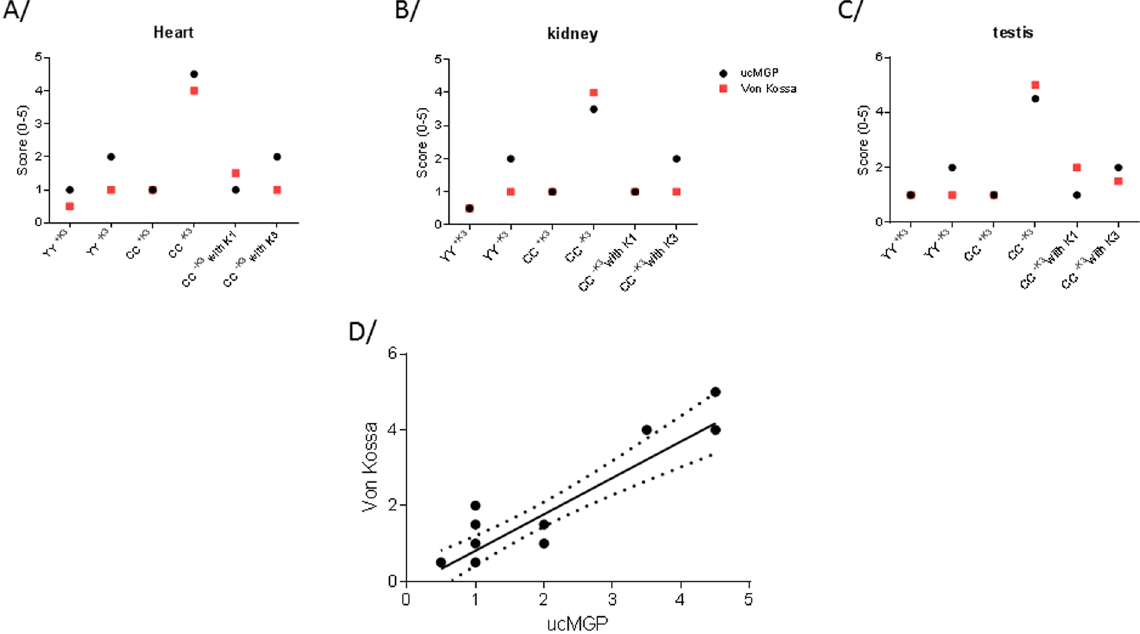
Figure 5. Score of ucMGP immunostaining and Von Kossa staining in heart ( A ), kidney ( B ) and testis ( C ) and correlation between ucMGP and Von Kossa staining ( D ). In D, the line corresponds to the linear regression with its 95% confidence interval in dot line.